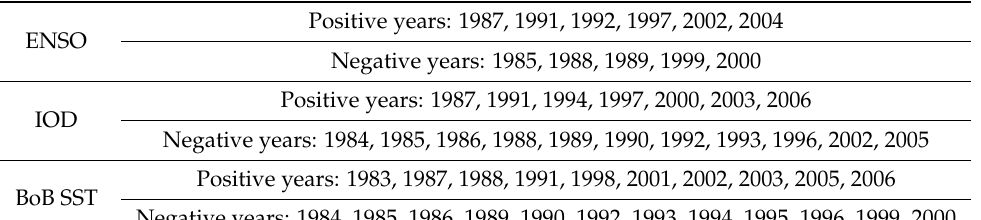
Table 2. List of SST status. For the selection of years, a threshold of ± 0.5 K was applied to ENSO/IOD